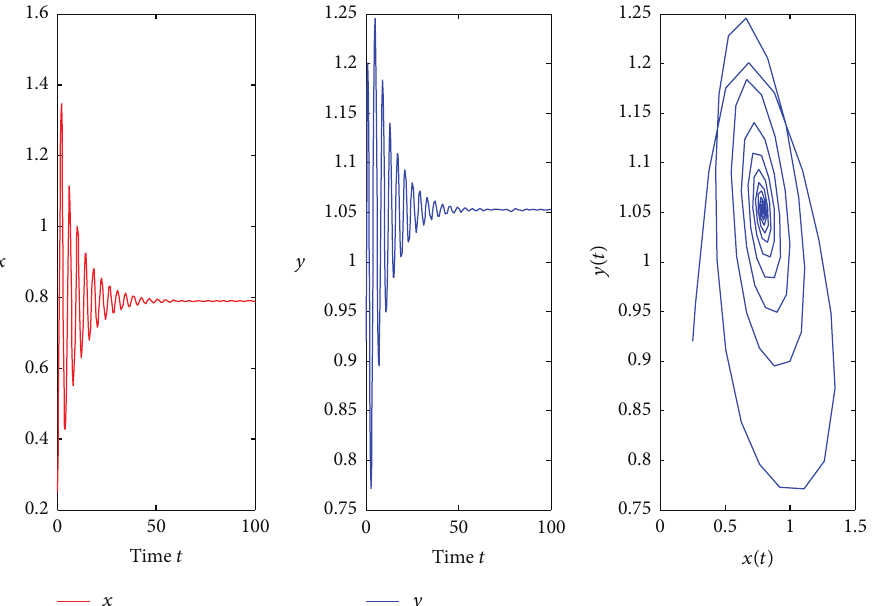
Figure 1: 𝐸 ∗ is asymptotically stable for 𝜏 1 = 0.95 < 𝜏 10 = 1.0241 with initial values “0.25;0.92.”